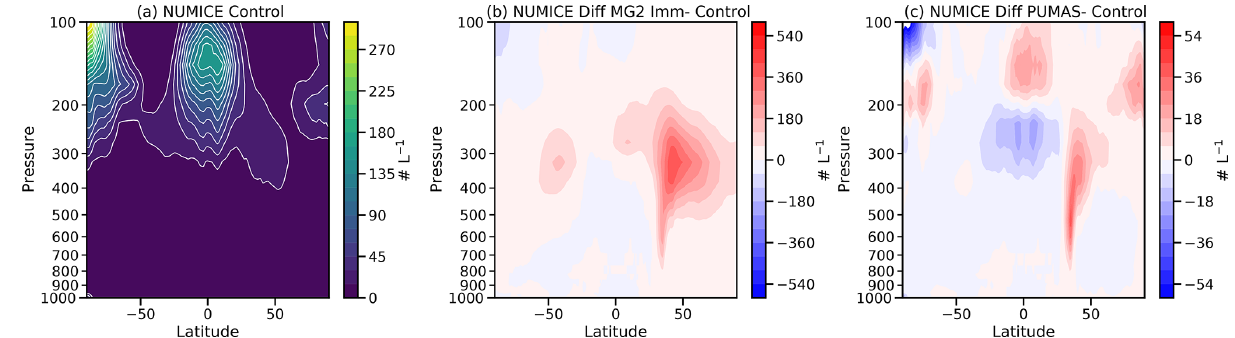
Figure 1. Zonal annual mean latitude height plots of the (a) cloud ice number (NUMICE) from the MG3 control simulation, (b) MG2 immersion freezing (no immersion limits in CNT dust) – control difference, and (c) PUMAS – control difference. Note the difference in scales between panels (b) and (c)